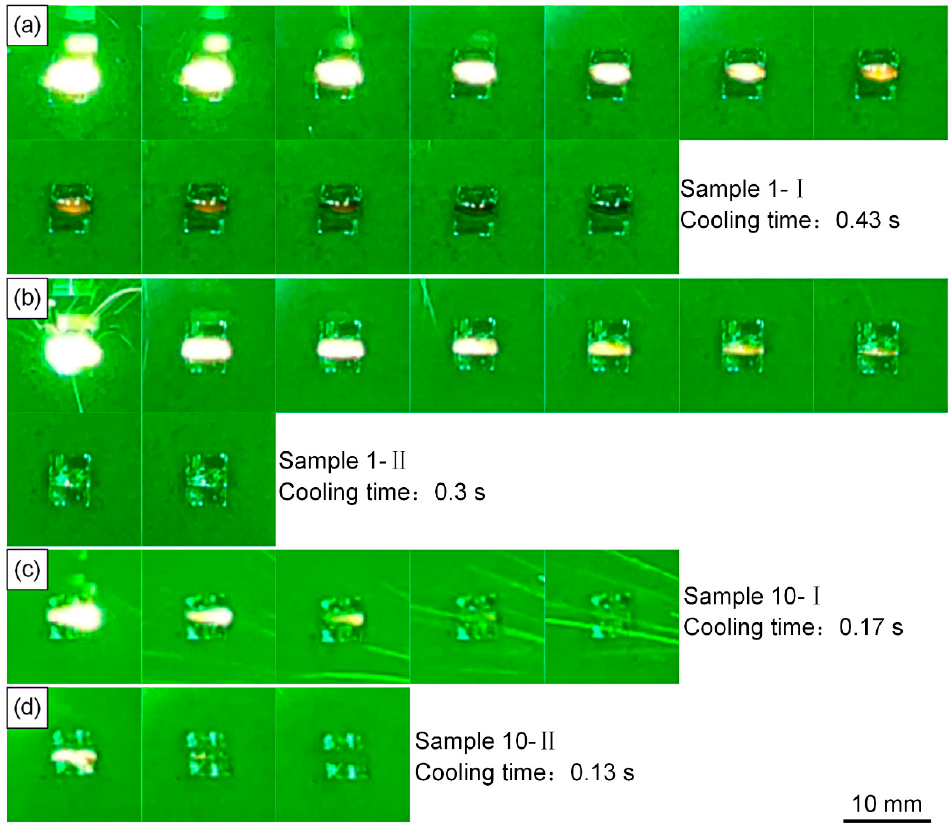
Figure 8. Pictures of the process of the first layer of the lower surface of the sample 1-I ( a ); 1-II ( b ); 10- I ( c ); and 10-II ( d ). ( c ); and 10-II ( d